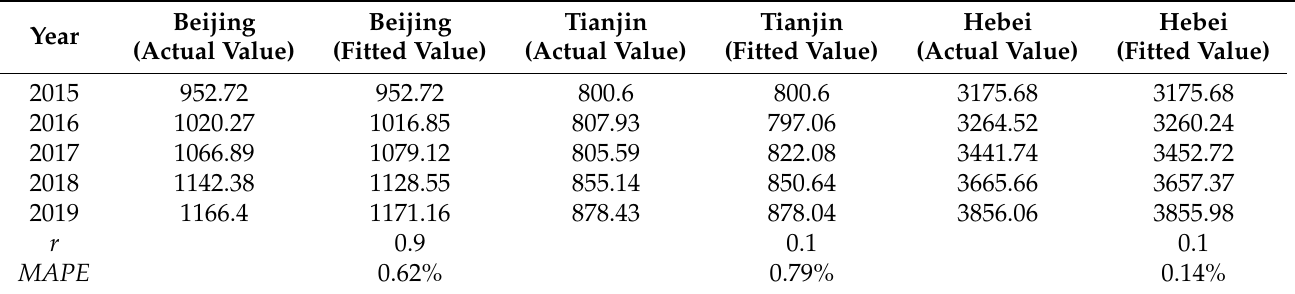
Table 2. The fitting values and MAPE values of other provinces’ power (100 million kW · h).